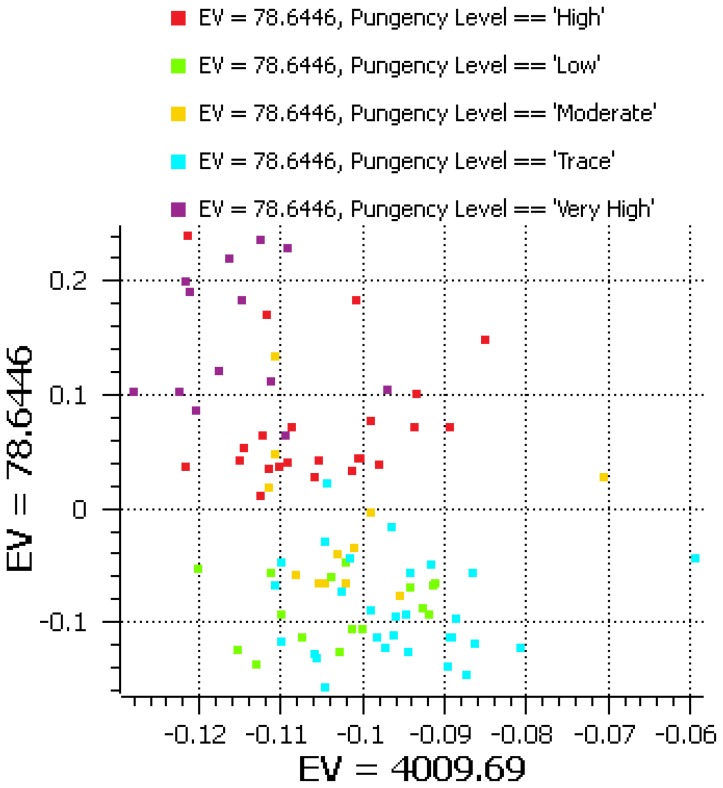
Principal component analysis of transformed concentrations of capsaicin pathway metabolites.Accessions are labeled by their pungency level (EV  =  eigenvalue).